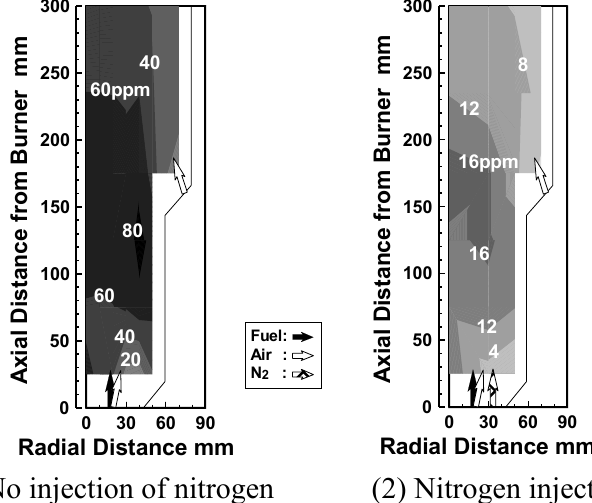
Figure 69. Effect of nitrogen injection on NOx production distributions using model